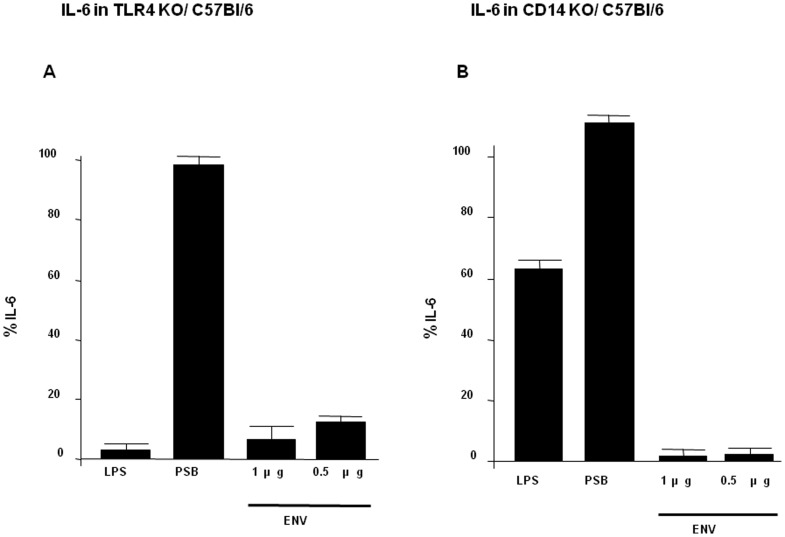
Comparison of IL6 production in Env-SU stimulated murine DC derived from TLR4 KO and CD14 KO mice compared with wild-type mice.IL-6 production in bone marrow DC culture supernatants of TLR4 KO (A) and CD14 KO (B) mice compared to wild-type C57BL/6 mice after 24 h of stimulation with LPS, PSB and graded dose of Env-SU. Percentages shown in the histogram correspond to the percentage of residual IL6 secretions dosed in cells supernatants of TLR4 or CD14 KO mice relative to wild-type mice. Data presented are representative of three experiments under identical conditions.